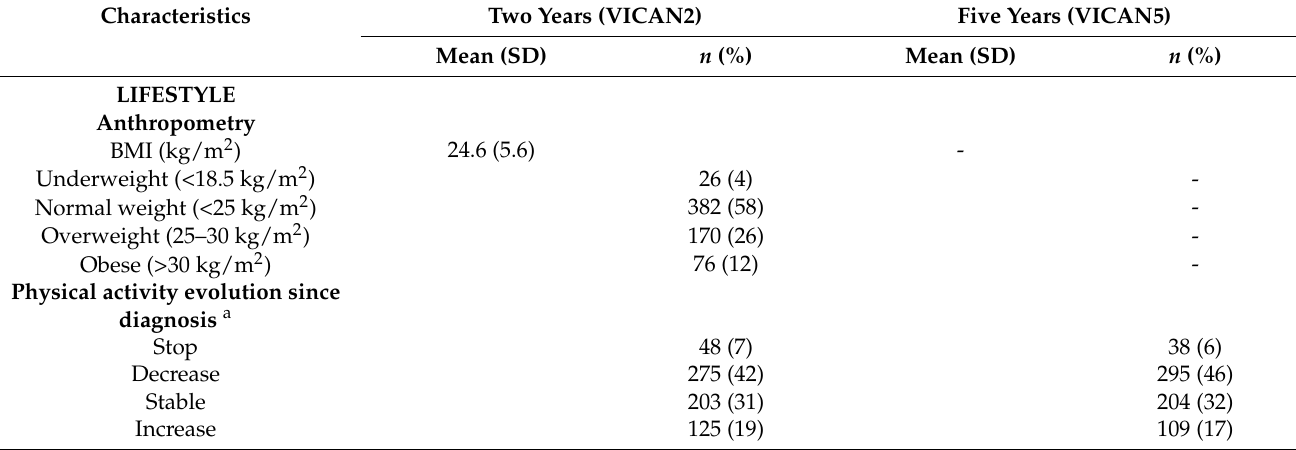
Table 2. Anthropometric measures, lifestyle factors, clinical data, and changes over time in sequelae at two and five years after diagnosis ( n = 654).